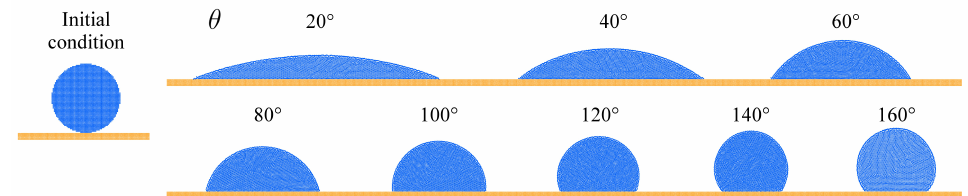
Figure 9. Initial setup and final states of wetting of a substrate for varied numerical contact angle parameter θ